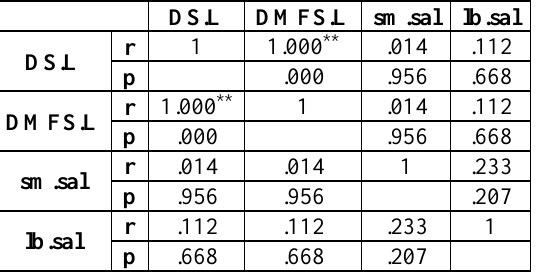
Table 6: Pearson correlation for lower permanent teeth with streptococcus and lacto bacillus bacteria level in